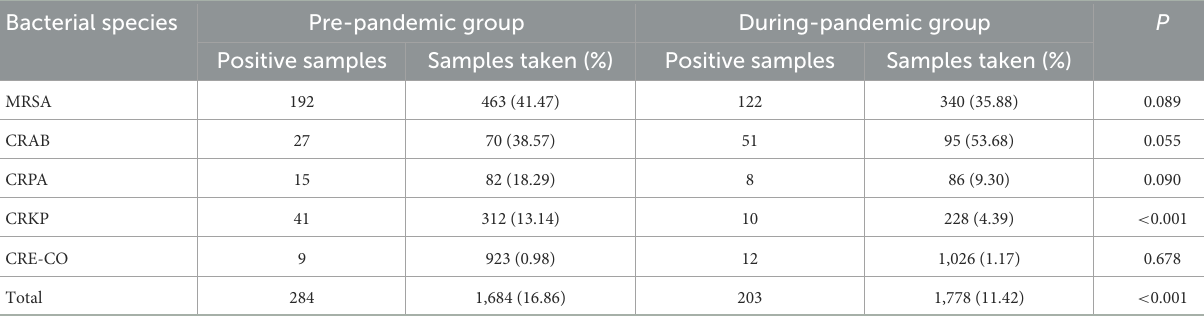
TABLE 2 Detection rate of multi-drug resistant bacteria pathogens (%). Bacterial species